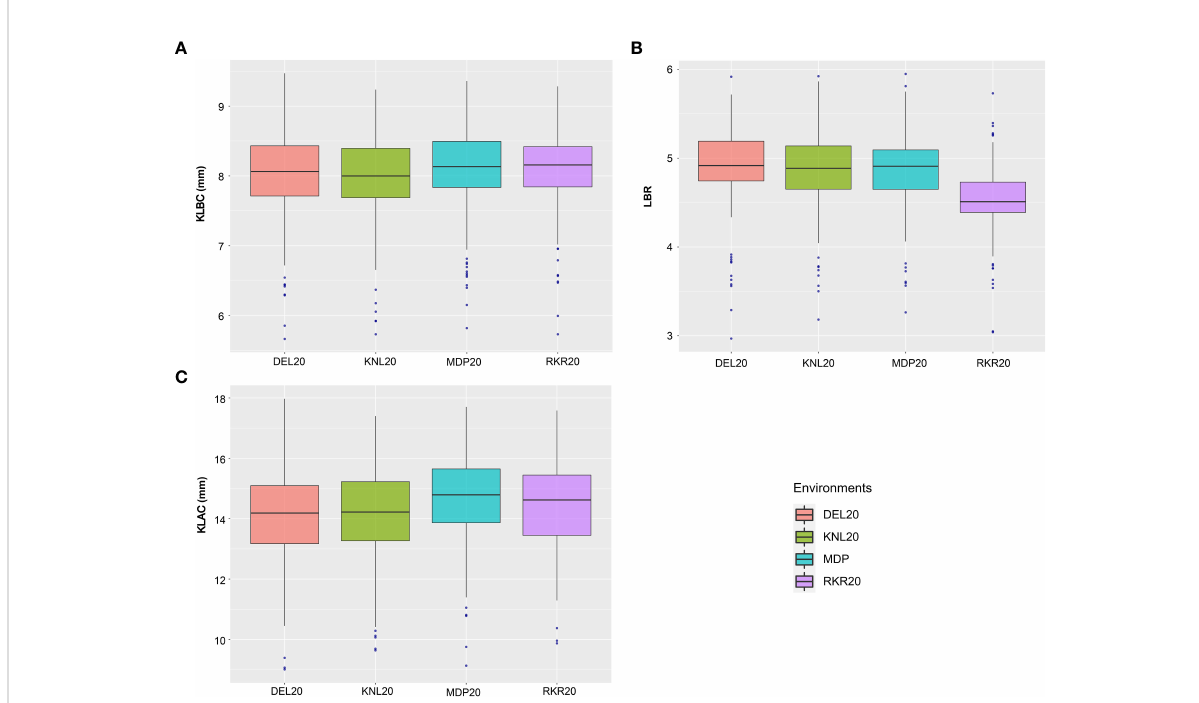
FIGURE 2 Boxplots depicting the distribution of (A) KLBC (mm), (B) LBR and (C) KLAC (mm) across across environments.